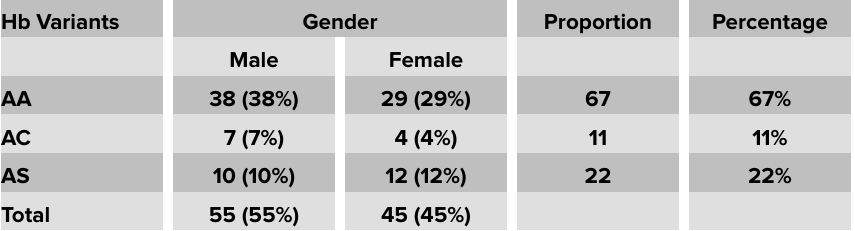
TABLE 2: Prevalence of hemoglobin phenotypes among voluntary blood donors.